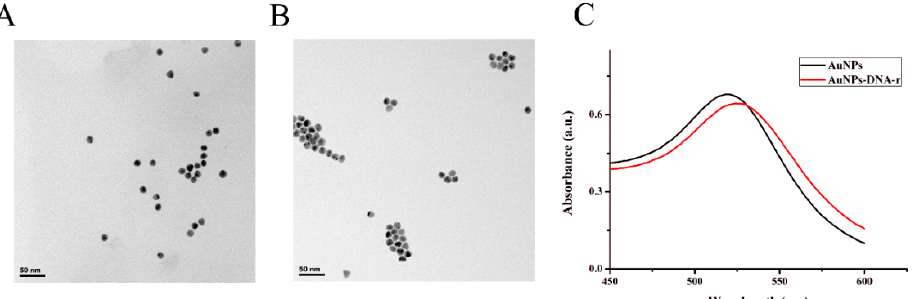
Figure 3. Transmission electron microscope (TEM) images of ( A ) AuNPs and ( B ) AuNPs-DNA-r. The scale value was 50 nm. ( C ) The ultraviolet-visible (UV-vis) absorption spectra of the AuNPs and the AuNPs-DNA-r. Black curve indicates the AuNPs and red curve indicates the AuNPs-DNA-r.